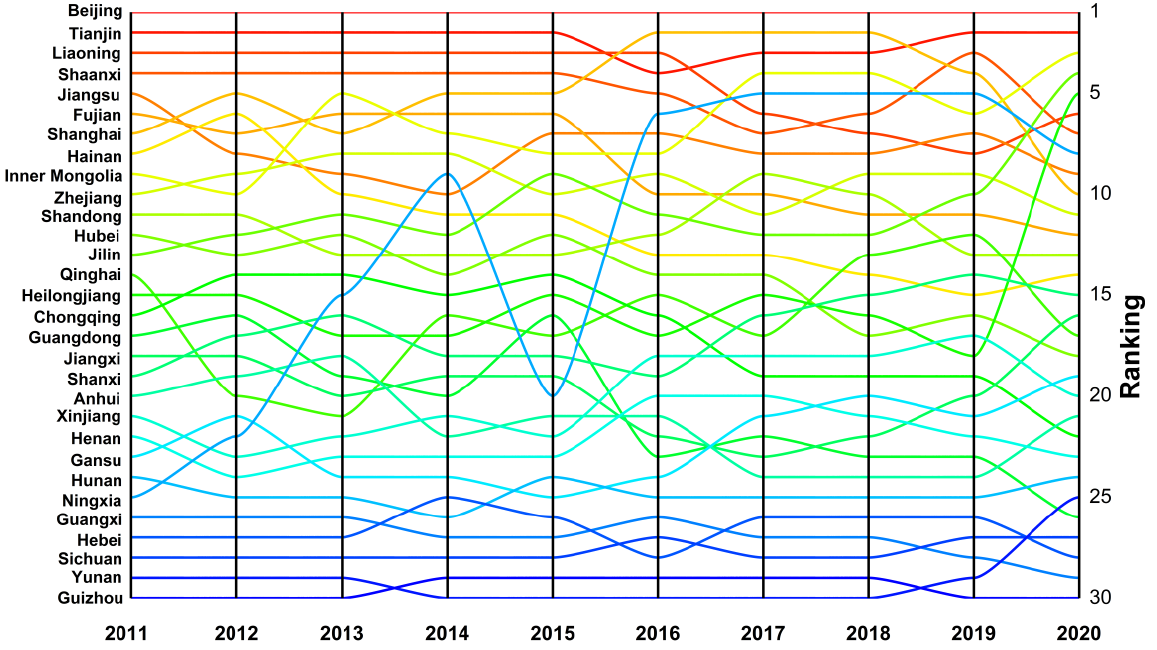
Figure 4. Changes in rankings of well-being scores of 30 provinces.